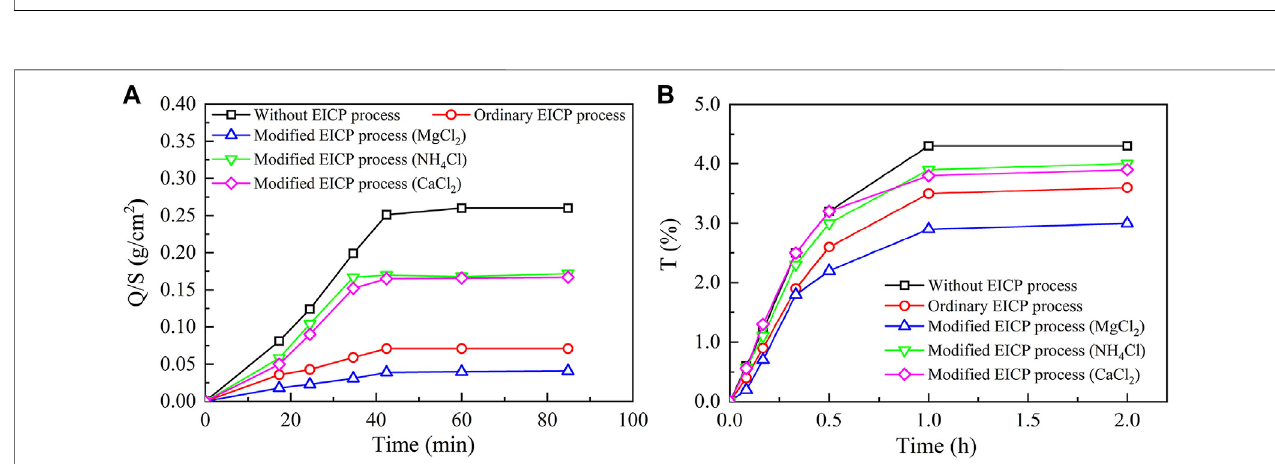
FIGURE11| Water-resistingperformanceoftheuntreated, ordinary EICP treated, and modi fi ed EICP-treatedbrick specimens: (A) water absorption tests and (B) air permeability tests.